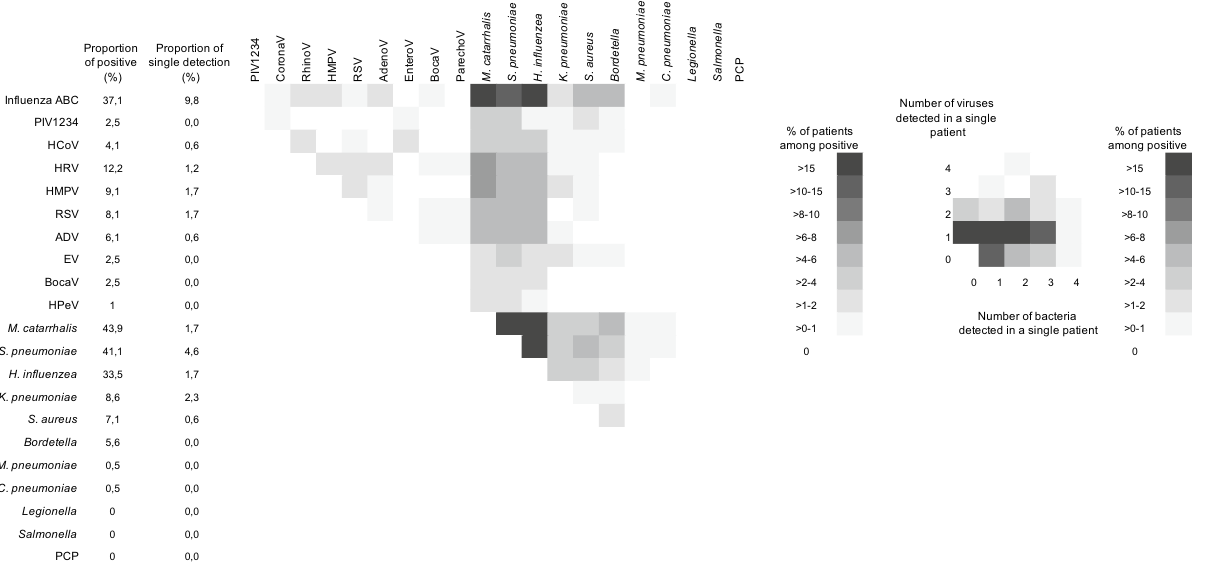
Figure 1. Single and multiple organism detection in ARI cases. PIV, parainfluenza virus; HCoV, human coronavirus; HRV, human rhinovirus; HMPV, human metapneumovirus; RSV, respiratory syncytial virus; ADV, human adenovirus; EV, enterovirus; BocaV, human bocavirus; HPeV, human parechovirus; PCP, Pneumocystis